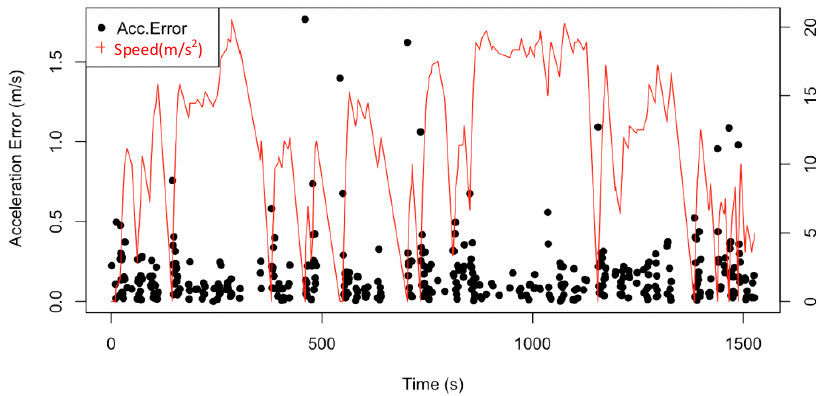
Figure 19. Acceleration detected error being performed with speed.